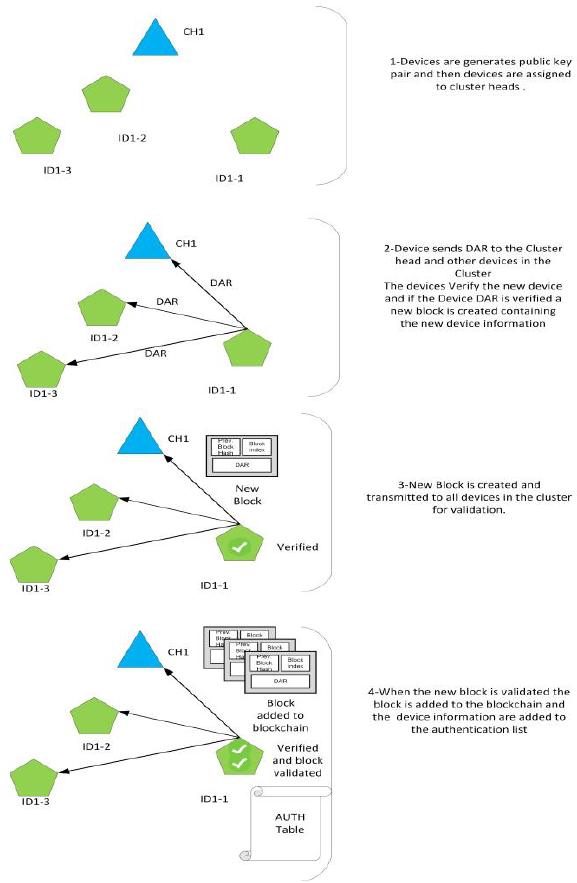
Figure 6. Authentication-Chains initialization process.